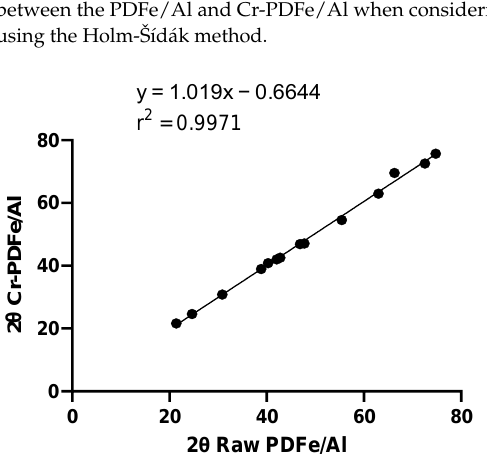
- 1 p -value for two tailed t -test comparison between EDS and XRF for PDFe/Al; 2 p -value for two tailed T-test comparison between EDS and XRF for Cr-PDFe/Al; 3 p -value for two-tailed T-test comparison between EDS data sets for PDFe/Al and Cr-PDFe/Al (5 repeat measurements each); 4 Only element showing a significant difference between the PDFe/Al and Cr-PDFe/Al when con- sidering the adjusted p -value significance level as calculated using the Holm-Šídák method. 3.1.3. BET Surface and Porosity Analysis Figure 5 and Table 4 depicts the porosity of the PDFe/Al before and after Cr(VI) adsorption using Brunauer-Emmet-Teller (BET). It is clear that a significant increase in both the internal surface area and volume was observed The total surface area of the raw PDFe/Al was reported to be around 37.5841 m 2 /g, which then changed to 95.5269 m 2 /g after Cr(VI) adsorption, while an eight-fold increase in internal pore volume (0.003 cm 3 /g to 0.02 cm 3 /g) was observed after Cr(VI) adsorption. These results are consistent with that observed previously for Congo Red adsorption [2]. The increased total surface area implies that the adsorbed chemical has the potential to enhance the adsorbent’s surface area, indicating the material’s potential for subsequent usage after Cr(VI) ion adsorption. Figure 6 depicts the nitrogen adsorption–desorption isotherms of the produced PDFe/Al before and after Cr(VI) adsorption. The adsorbed quantities increased as rela-